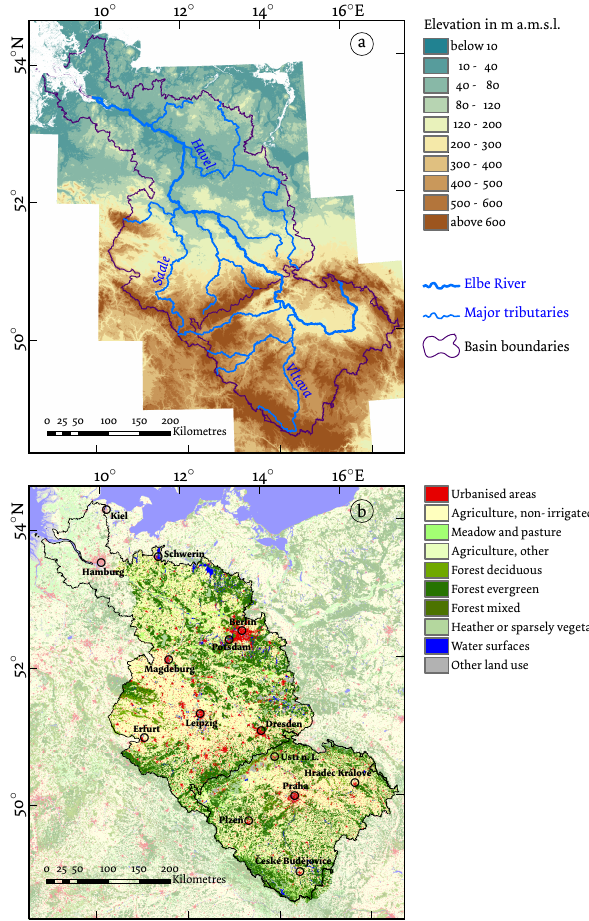
Fig. 2. The Elbe Basin in central Europe: (a) elevations and ma- jor tributary streams. (b) Land use according to the CORINE2000 classification; saturated tints indicate the model domain.